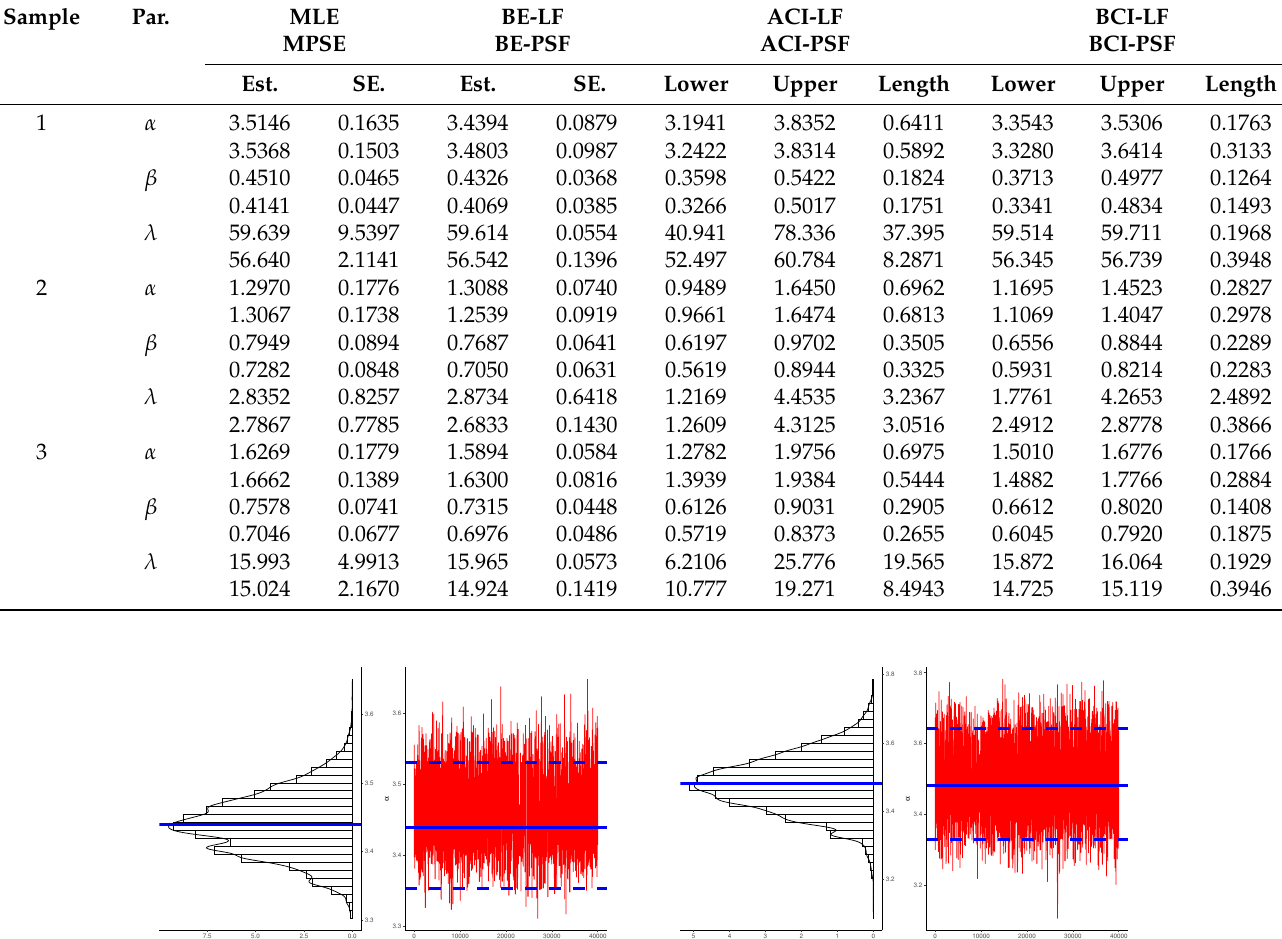
Table 9. Point and interval estimates of α , β , and λ from LED data.